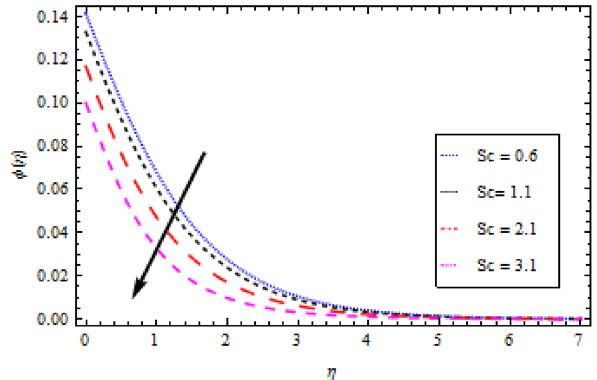
Figure 13. Concentration profile variation with respect to Sc .